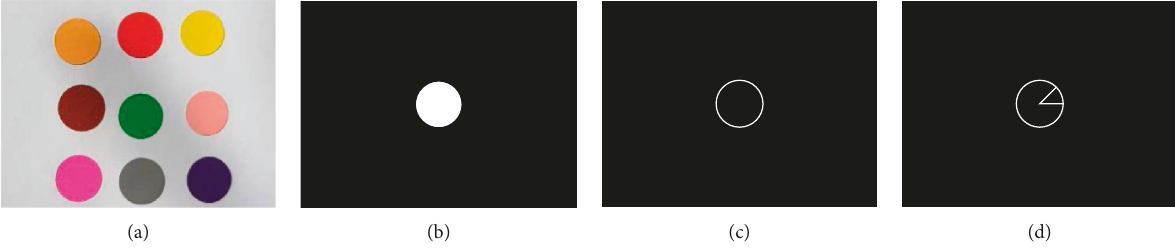
Figure 5: Algorithm detection effect. (a) The original image. (b) Color extraction in HSV. (c) Edge detection. (d) Hough’s circle